Question: Generate an informative caption for the figure above.
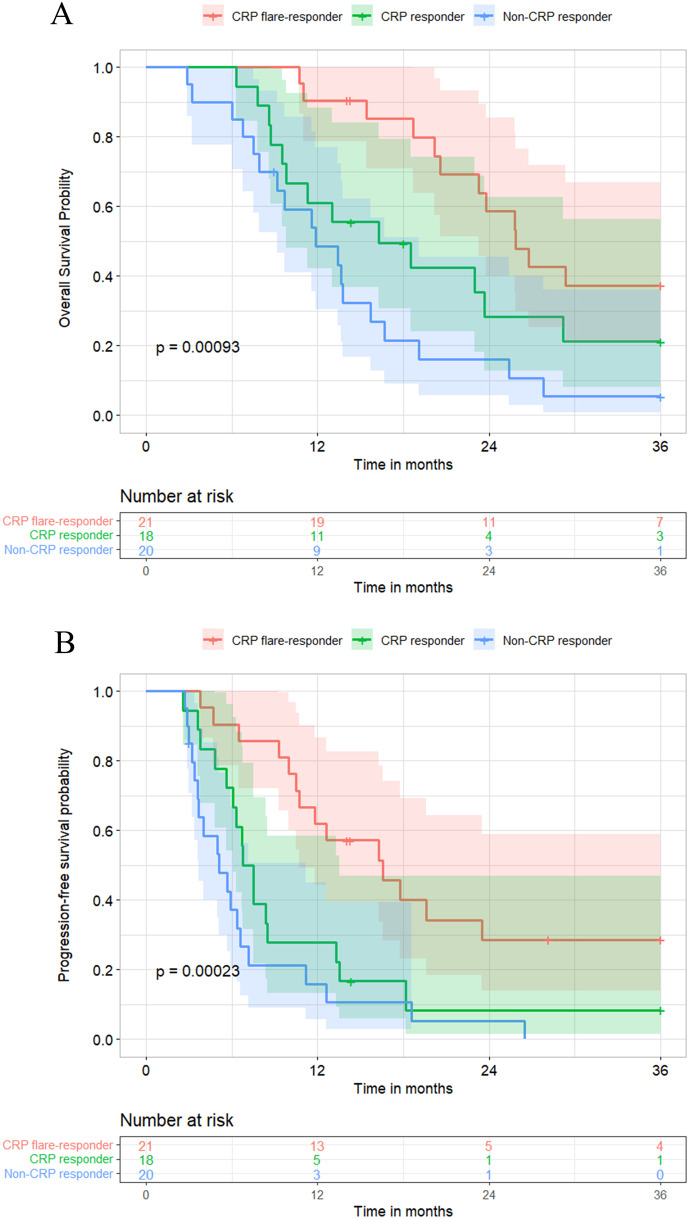
Answer: (A) overall survival curves and (B) progression-free survival curves based on early CRP kinetics.